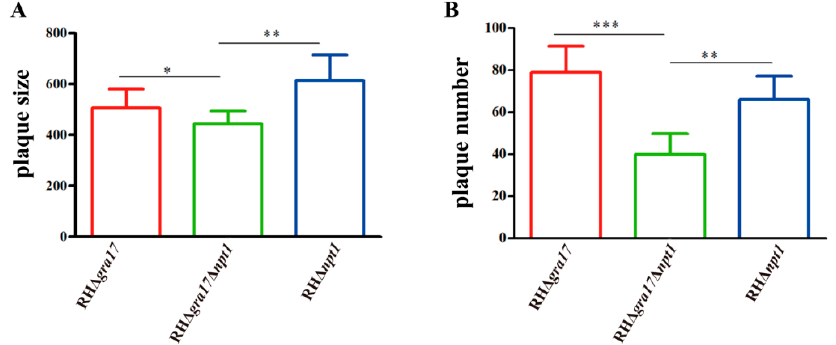
Figure 3. In vivo and in vitro growth of RH ∆ gra17 ∆ npt1 . Approximately 10 3 tachyzoites of RH ∆ gra17 , RH ∆ npt1 , or RH ∆ gra17 ∆ npt1 were i.p. inoculated into mice. Five days later, the parasite burden in the peritoneal fluid was evaluated using the in vitro plaque assay. The data represent the mean ± standard deviation (SD) of the relative size ( A ) and number ( B ) of the plaques generated by tachyzoites of each